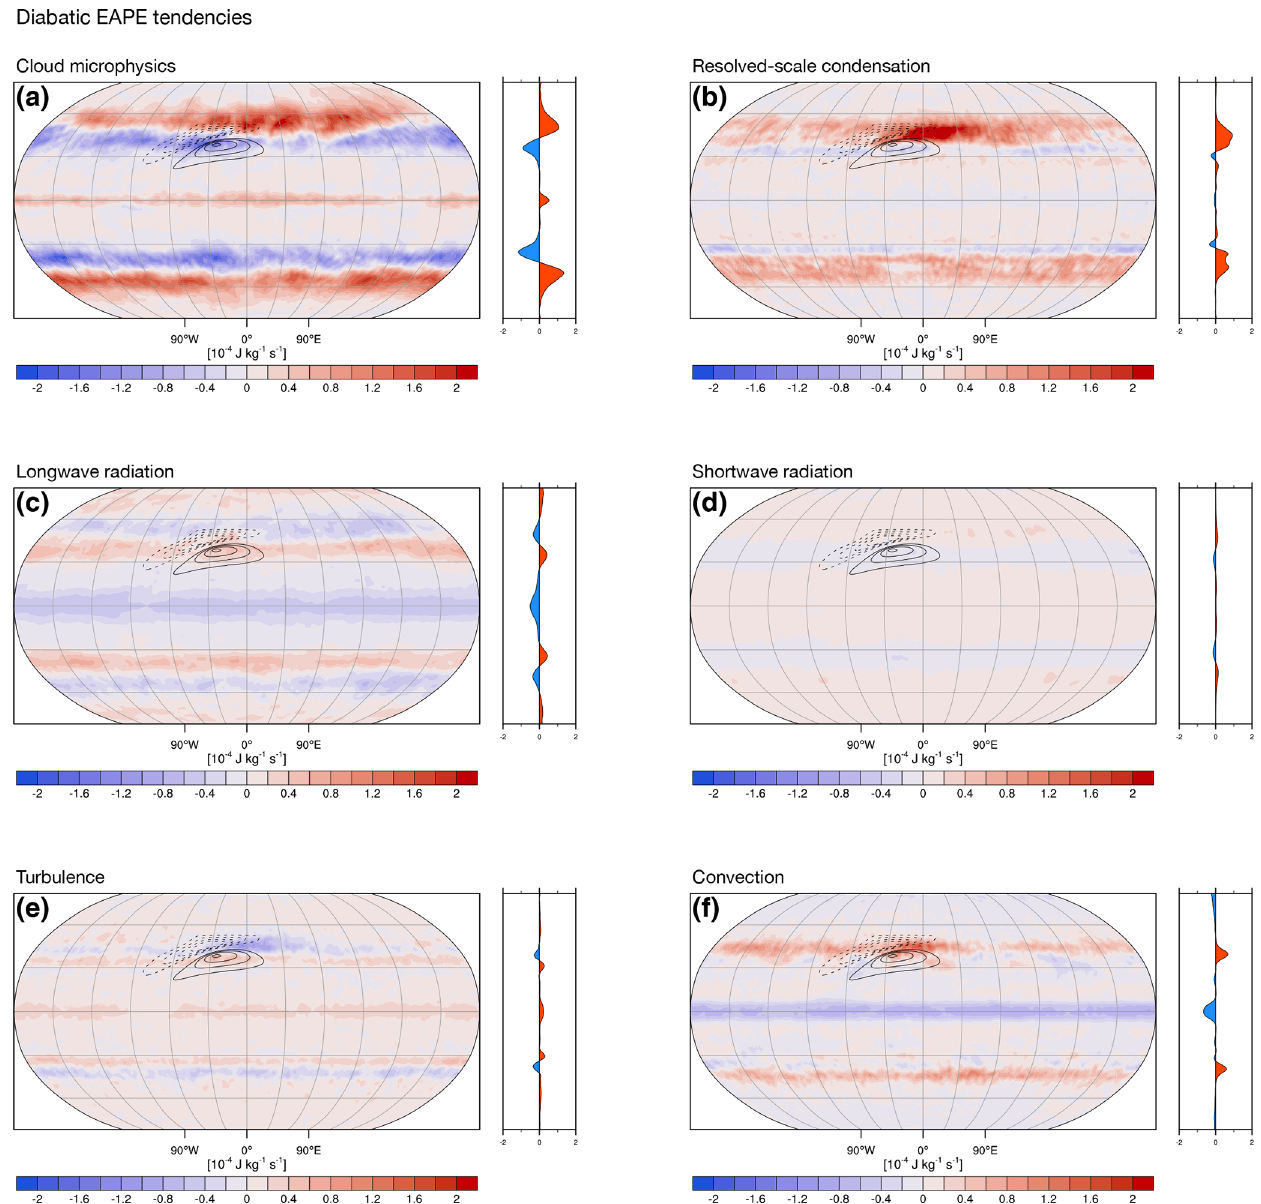
Figure 5. Mass-weighted vertically averaged change of different diabatic EAPE tendencies between the warmed and control simulations due to (a) cloud microphysics, (b) saturation adjustment, (c) longwave and (d) shortwave radiation, (e) turbulence, and (f) parameterized convection (color shading). Vertical averages are taken between